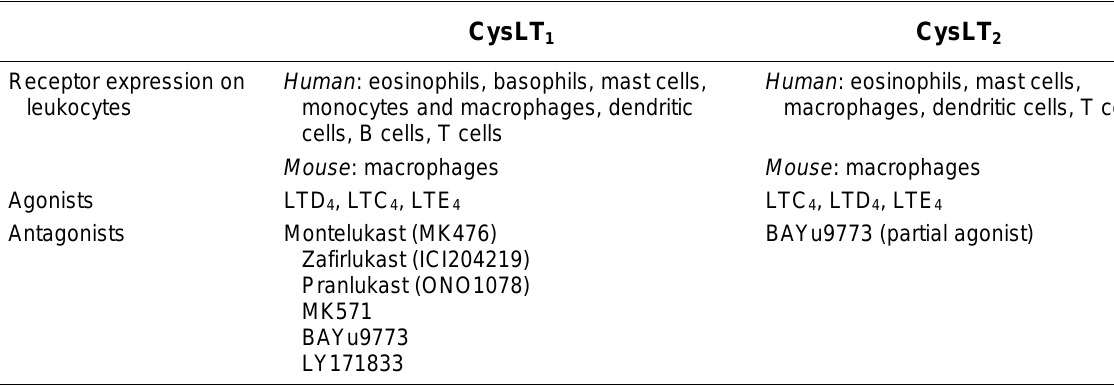
and CysLT CysLT 1